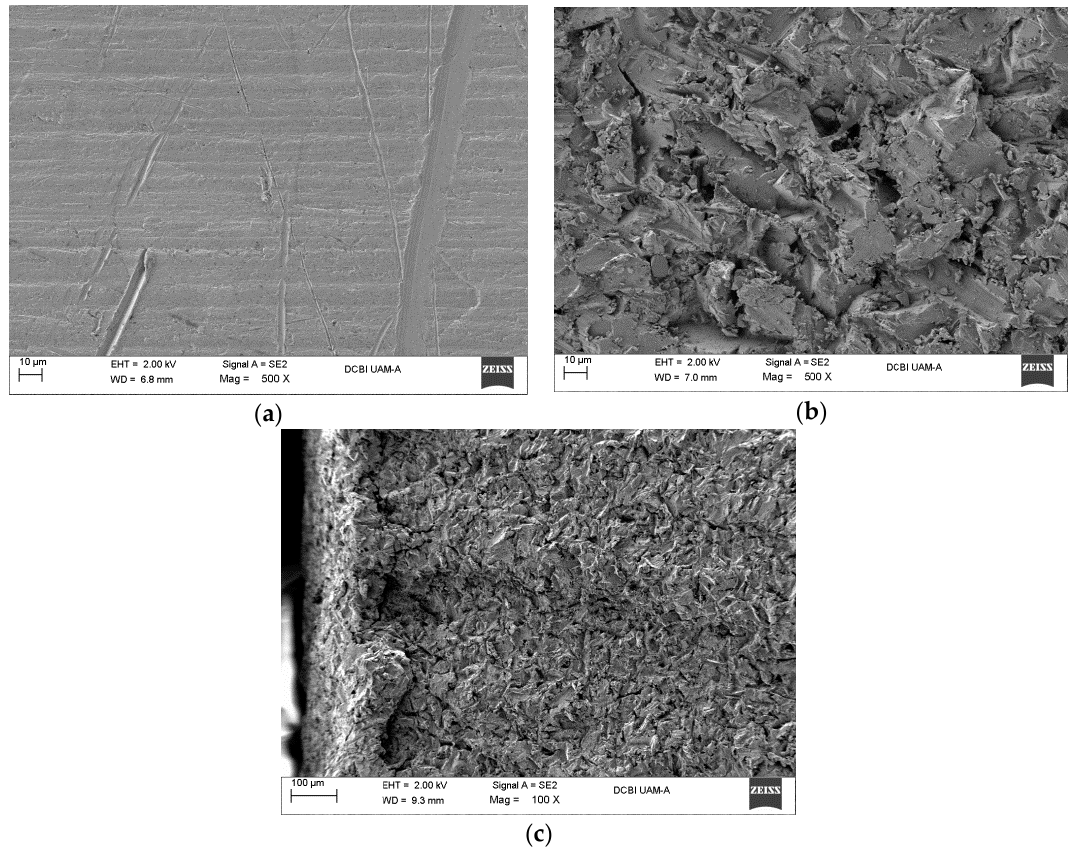
Figure 5. Surface topological features of sandblasted aluminum surfaces: ( a ) Top view of a commercial aluminum at 500×; ( b ) Top view of a commercial aluminum with sandblasting at 500×; ( c ) Lateral view of sandblasting at 100×.